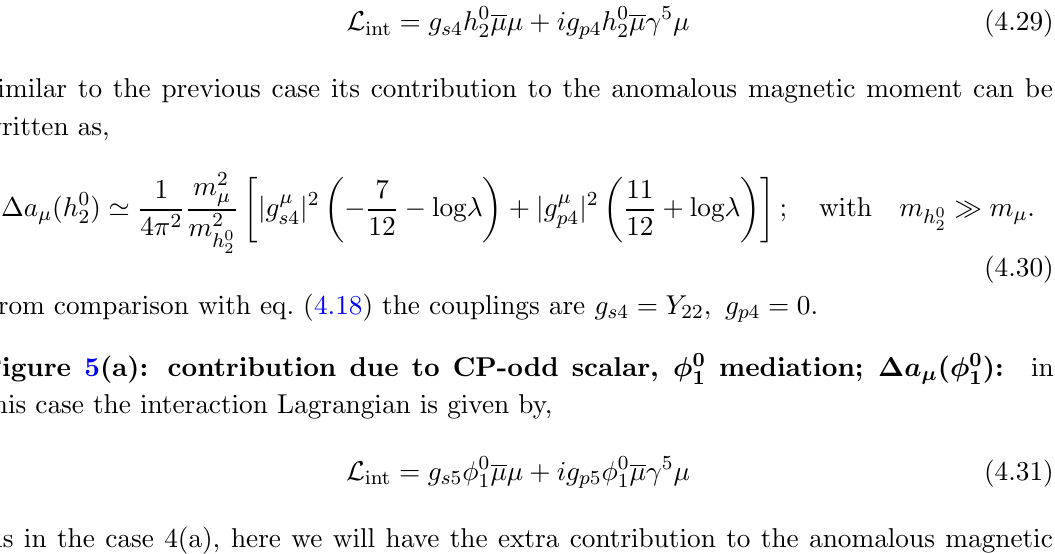
The result in eq. (4.28) is for general neutral scalars with scalar and pseudo-scalar couplings in the regime m Neutral Scalar m (cid:22) . The contribution coming from pure scalar can be (cid:29) derived from eq. (4.28) by setting the pseudo-scalar coupling ( g p ) to zero and that from pseudo-scalar by setting the scalar coupling ( g s ) to zero. By comparing with eq. (4.18) we have the couplings g s 3 = ~ Y 22 ; g p 3 = 0. Figure 4(b): contribution due to CP-even scalar, h 0 mediation; (cid:1) a ( h 0 ): for (cid:22) 2 2